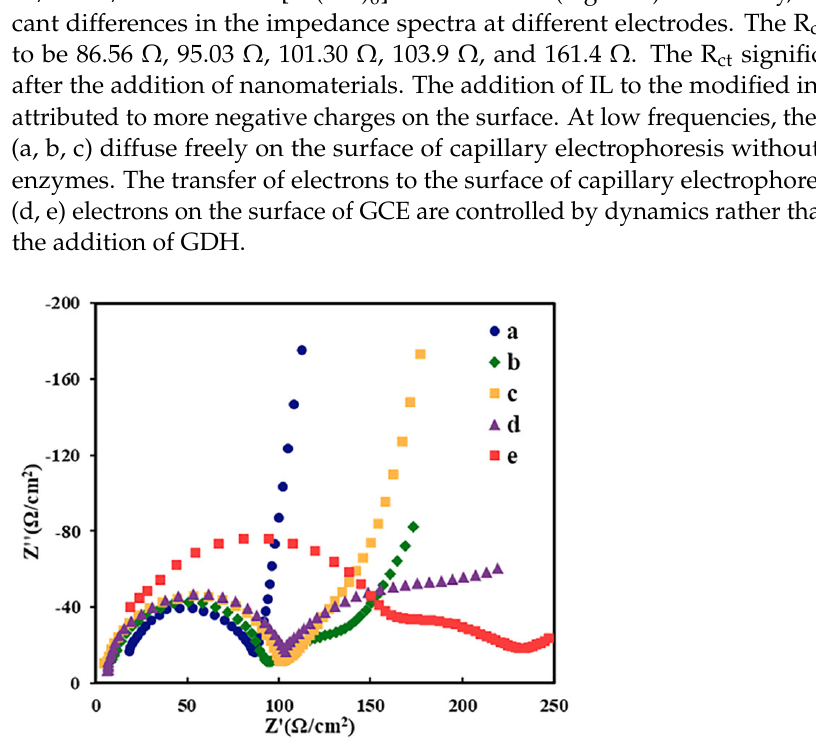
Figure 9. Peak current of the NF/GDH/IL/mPEG-fMWCNTs-modified GCE versus ( A ) cycle fre- quencies (1, 20, 40, 60, 80, and 100 cycles). ( B ) Storage stability (1, 7, 14, 21, and 28 days). The exper- iments were conducted in PBS (50 mM, pH 7.0) versus Ag/AgCl. at scan rate of 0.05 V s − 1 , 25 ± 1 °C. Long-term storage stability is another important factor affecting the commercial use of the sensor. The modified electrodes were stored in a desiccator at 4 °C. We then further studied peak currents over the course of 28 days by cyclic voltammetry. The peak current decreased because enzyme activity decreased during storage, and then the current density slowly decreased. The peak current lost approximately 18% of its original value, thus in- dicating that the modified GCE was stable in storage. Nafion polymer films effectively protected the electrode from damage. 3. Materials and Methods 3.1. Reagents and Materials NAD(P)+-dependent GDH (EC 1.1.1.47, from Bacillus subtilis ) was derived from di- rected evolution in our laboratory (Kaifeng, China) [49]. NaH 2 PO 4 , Na 2 HPO 4 , NADP + , su- crose, lactose, ethanol, propanol, lactic acid and β -D- (+)-glucose were purchased from